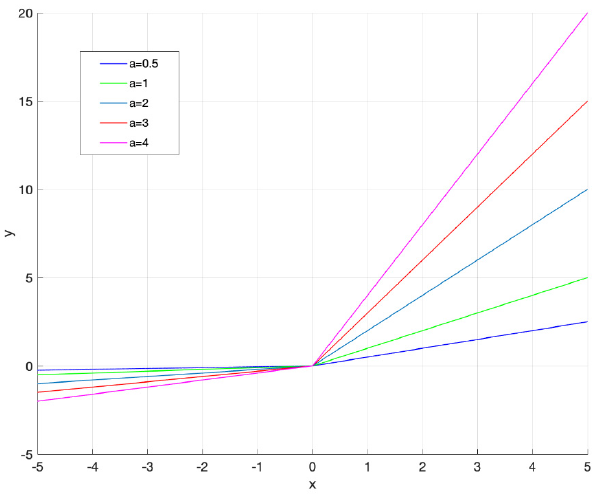
Figure 1. Proposed activation function LeLeLU for various values of α .